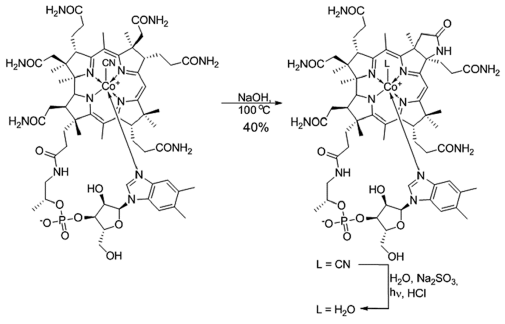
Figure 1. Synthesis of (OH)Cbl( c